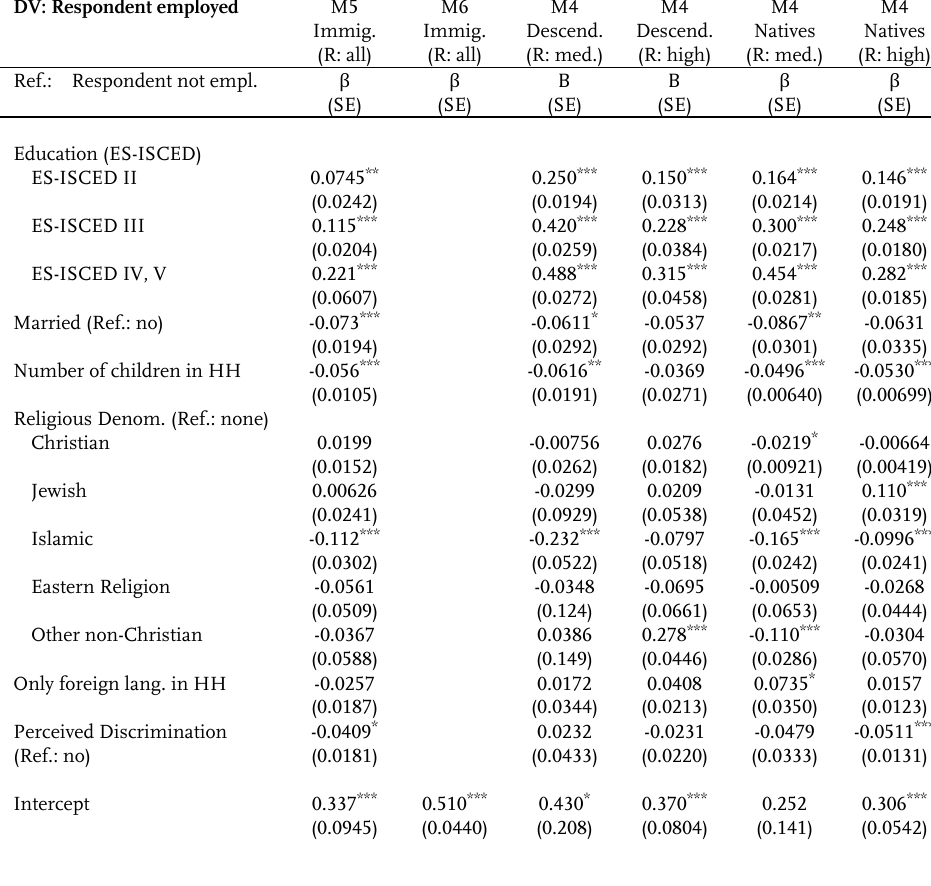
Table A.5 : Full models M5 and M6 for immigrants, M4 for descendants and natives